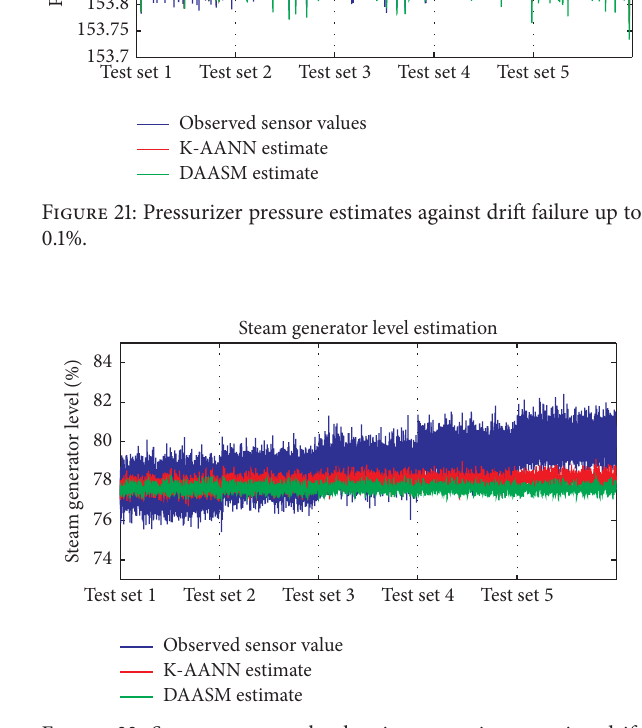
Figure 22: Steam generator level estimates against growing drift failure up to